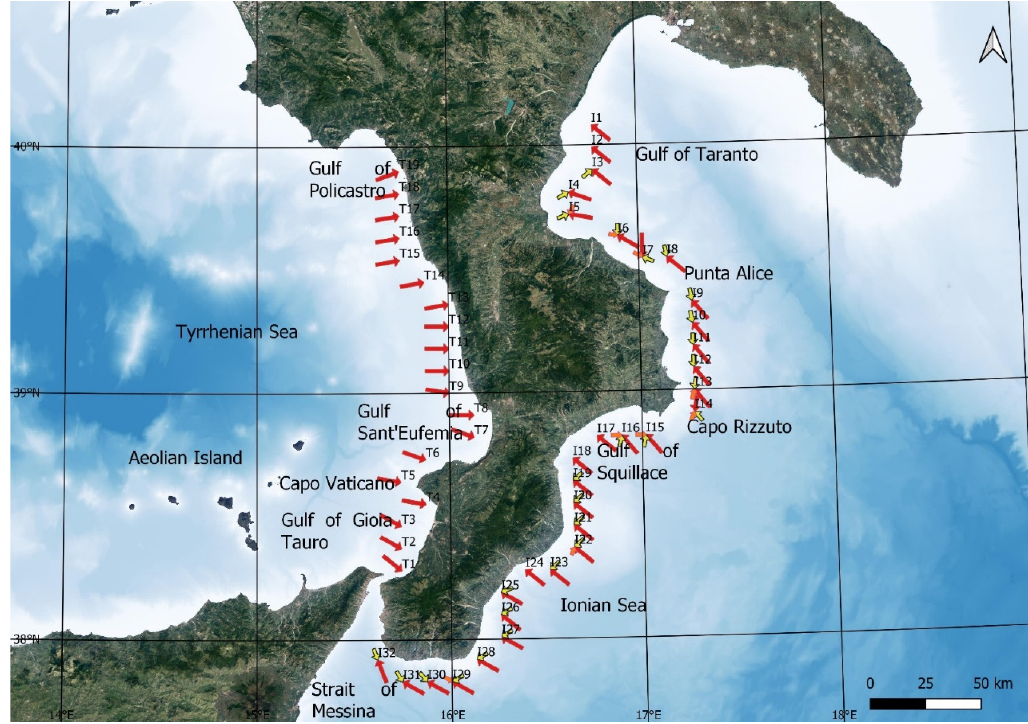
Figure 9. Main, secondary, and tertiary energy sector directions. Legend: main sectors MS are in red, secondary sectors SS are in yellow, and tertiary sectors TS are in orange.